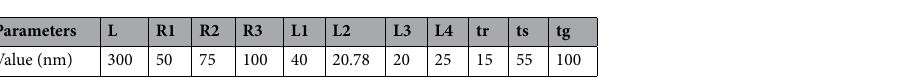
Table 1. Parameter List of the proposed